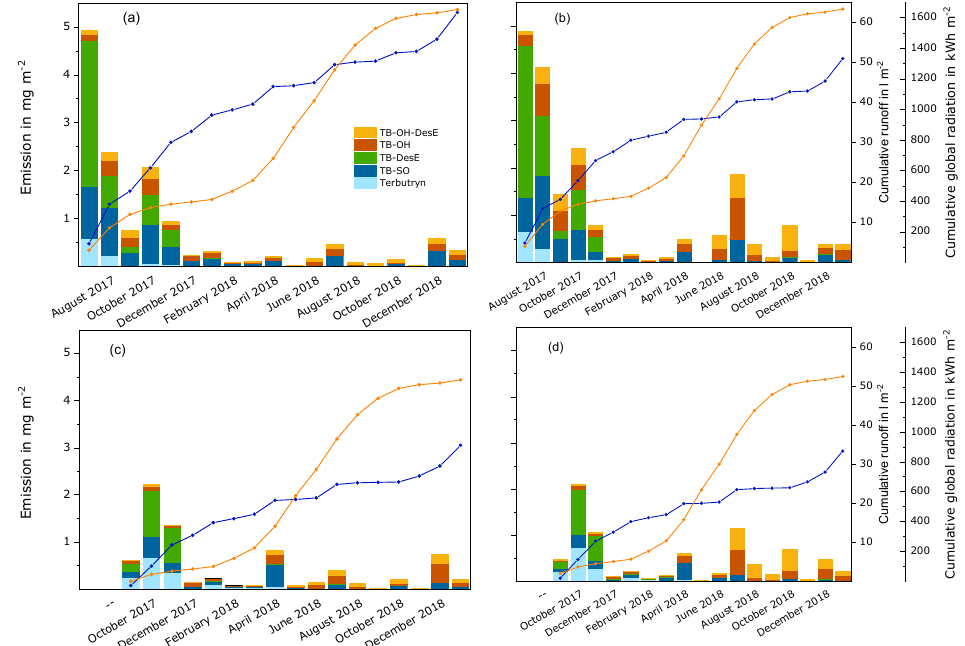
Figure 1. Monthly emissions of terbutryn and transformation products from a white and a red paint film during semi-field experiments that were started in July 2017 (experiment A) and September 2017 (experiment B). The columns represent the substances that were detected in runoff samples per month. The blue curves show the cumulated volume of runoff samples per surface area for each experiment. The orange curves show the cumulative global radiation during the experiment. ( a ) Experiment A, white paint; ( b ) experiment A, red paint; ( c ) experiment B, white paint; ( d ) experiment B, red paint. The emission curves of the different substances do not run in parallel. Terbutryn